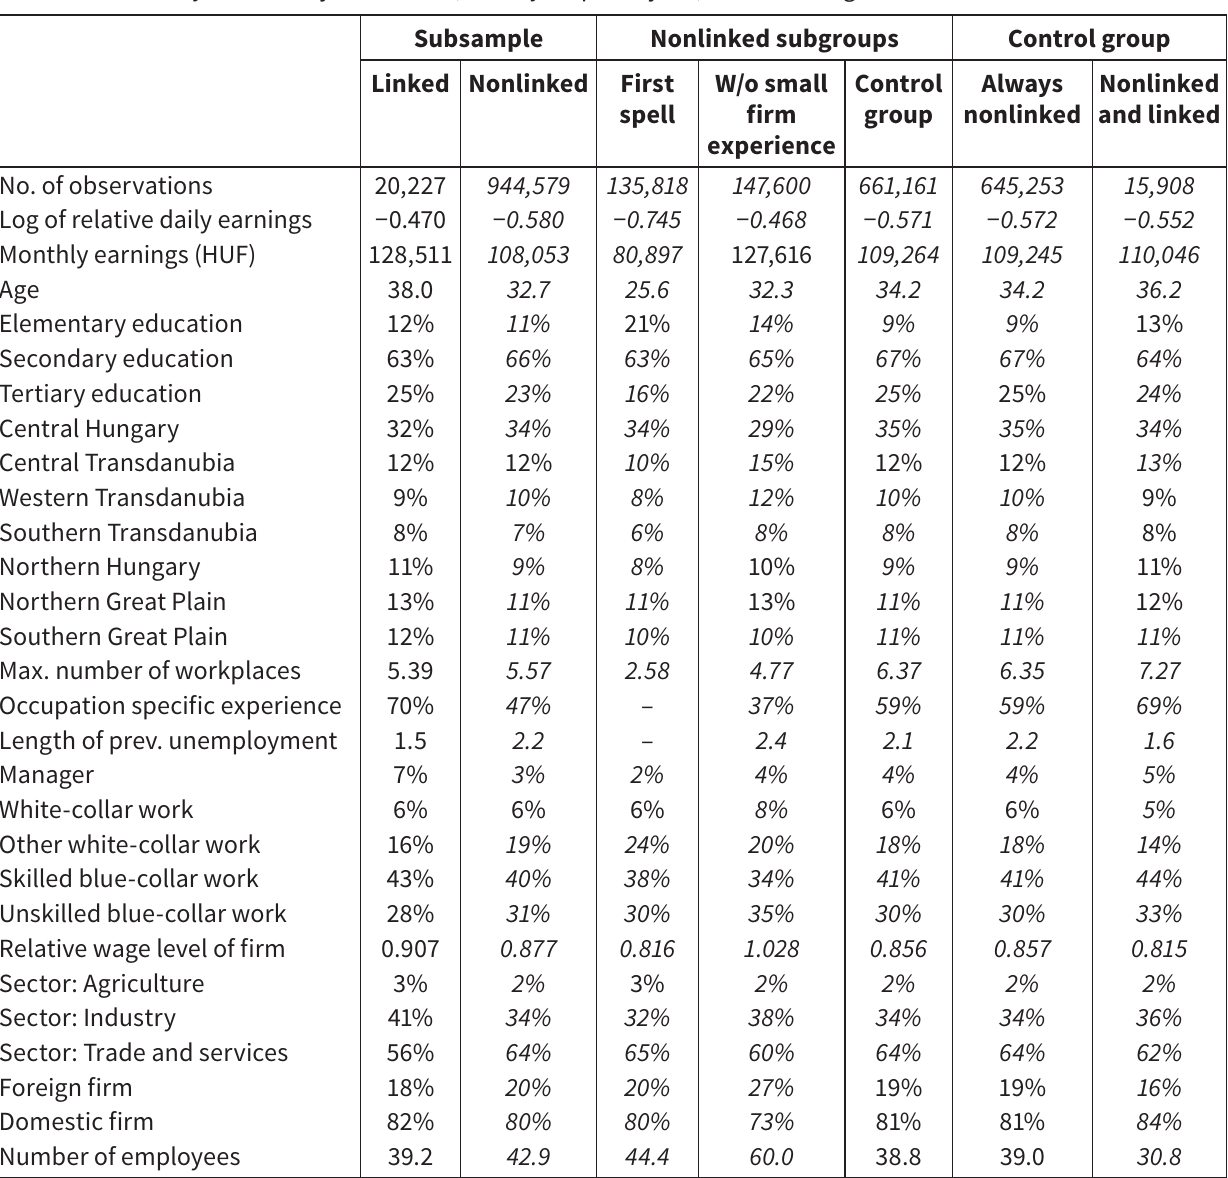
Summary statistics: job entrants, freshly acquired jobs, and receiving